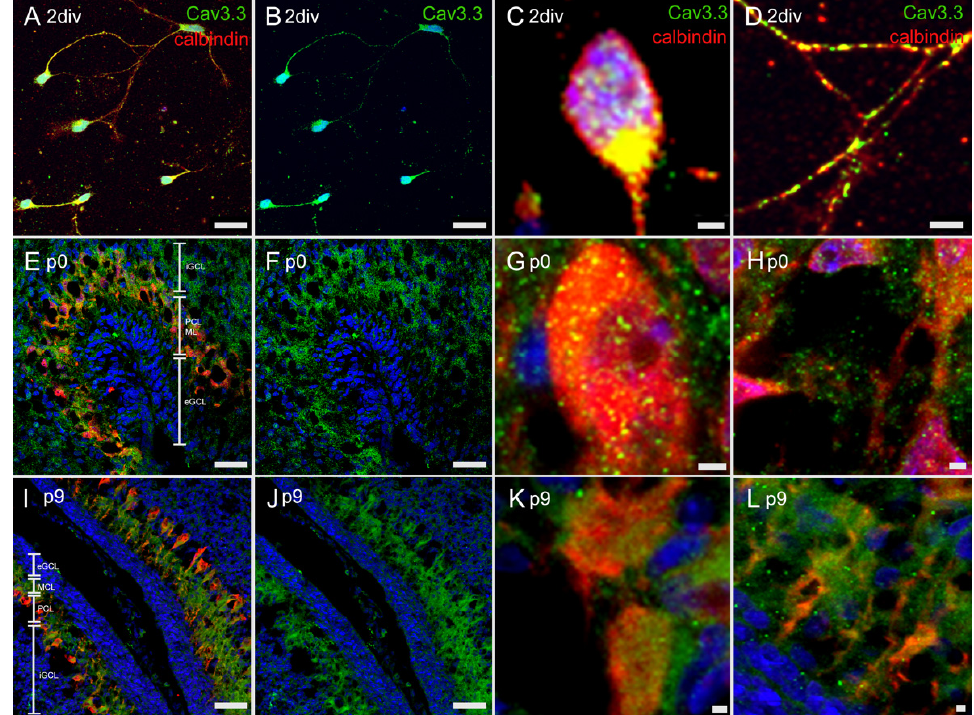
Figure 6. In vivo and in vitro expression of Cav3.3: Immunostaining of Cav3.3 in dissociated PCs at 2div ( A – D ), and in cryosections of rat cerebella at p0 ( E – H ) and p9 ( I – L ). Cav3.3 was stained green, calbindin red, and nuclear staining was performed with Hoechst (blue). In the PC culture, Cav3.3 was localized at the soma and along the dendrites or axons, whereas in cryosections of p0, cerebella staining of Cav3.3 was visible mainly near to the soma. In 9-day-old PCs, the Cav3.3- antibody strongly marked the ML, where the PC dendrites are localized. eGCL = external granular